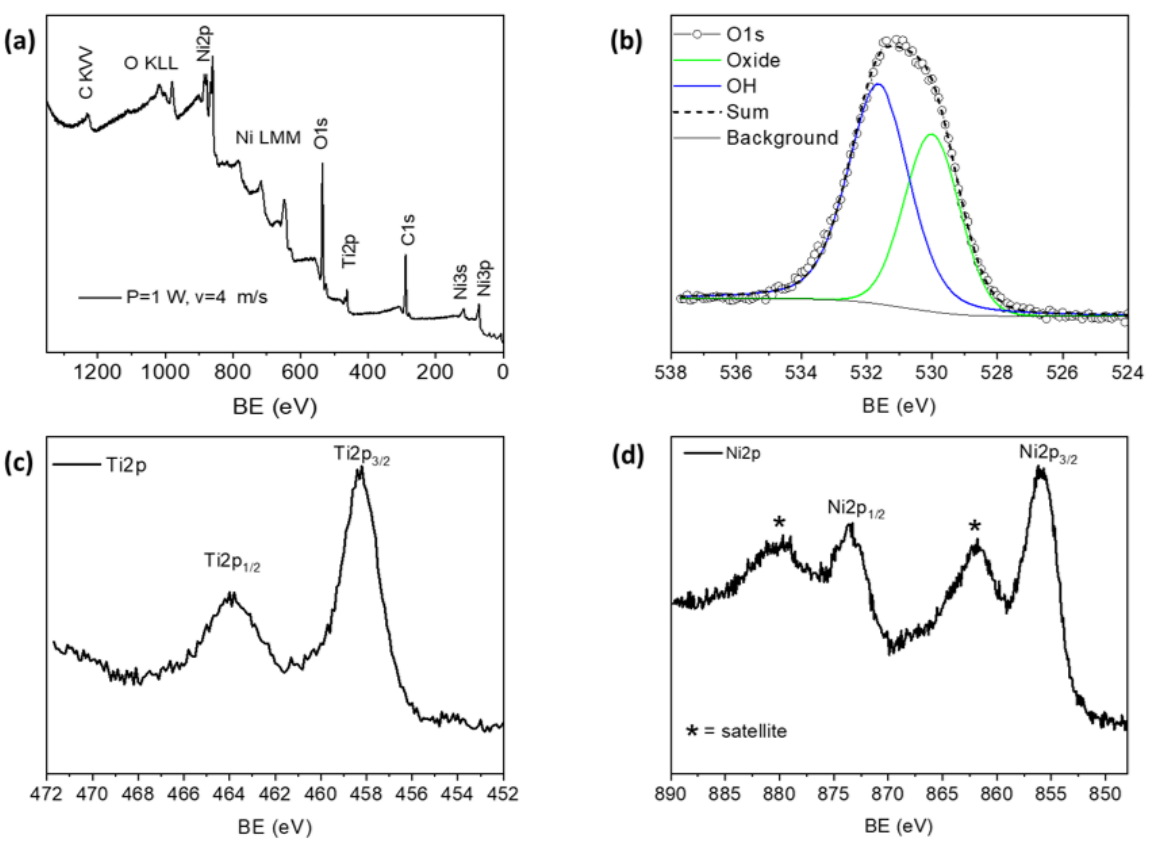
Figure 9. Representative XPS survey ( a ) and detailed scans ( b – d ) for the sample P = 1 W, v = 4 m/s.